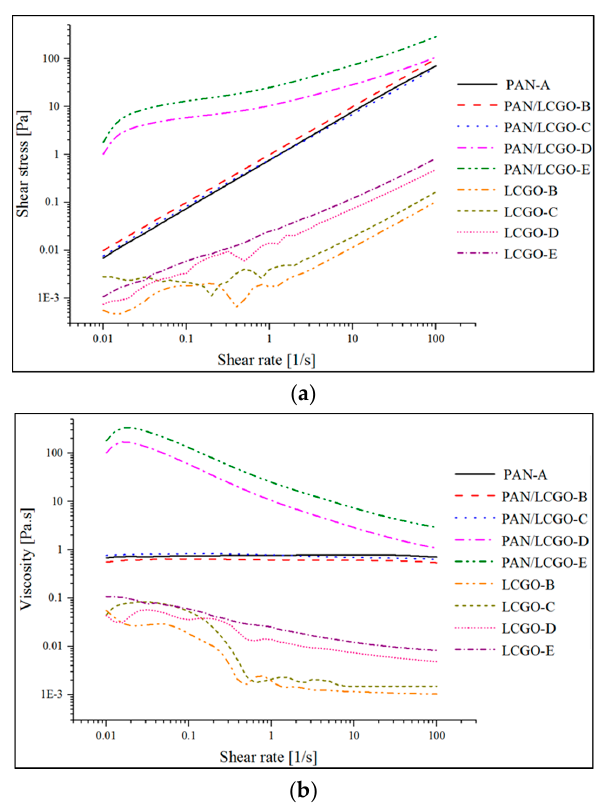
Figure 1. ( a ) Shear stress and ( b ) viscosity vs. shear rate curves of liquid crystal graphene oxide (LCGO) dispersions in N , N -dimethyl formamide (DMF) and polyacrylonitrile (PAN) and PAN/LCGO dispersions in DMF.